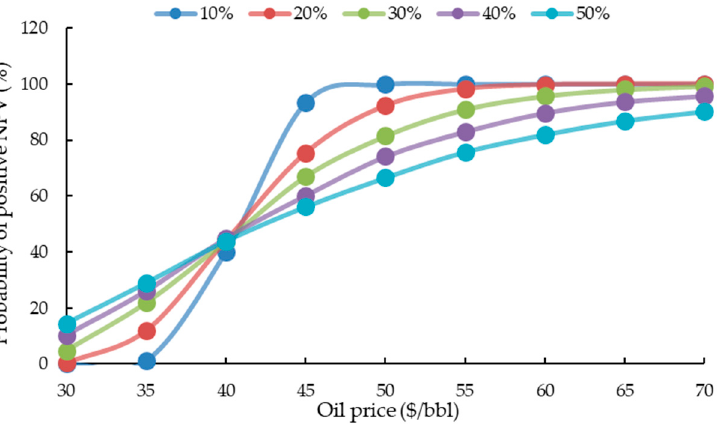
Figure 9. Probability of positive NPV under different oil prices (considering fluctuation range).